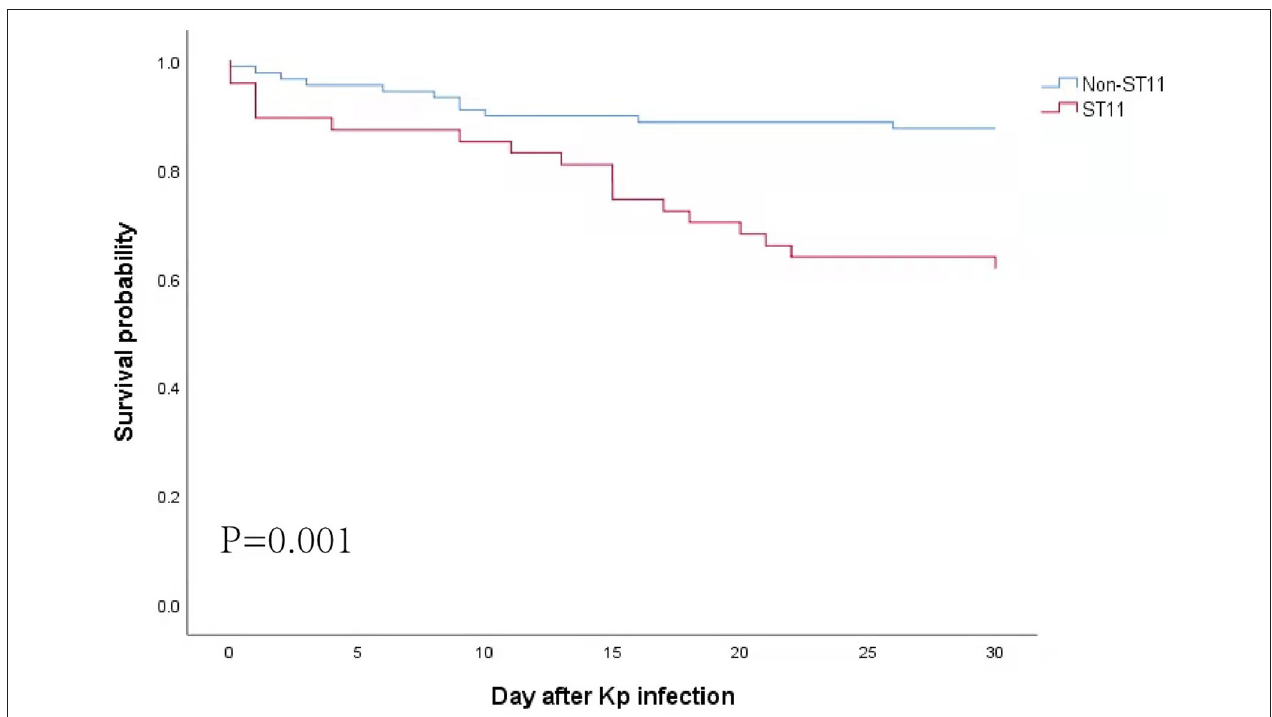
FIGURE 3 | Kaplan–Meier curves for all-cause 30-day mortality. Statistical significance was determined by the log-rank test.